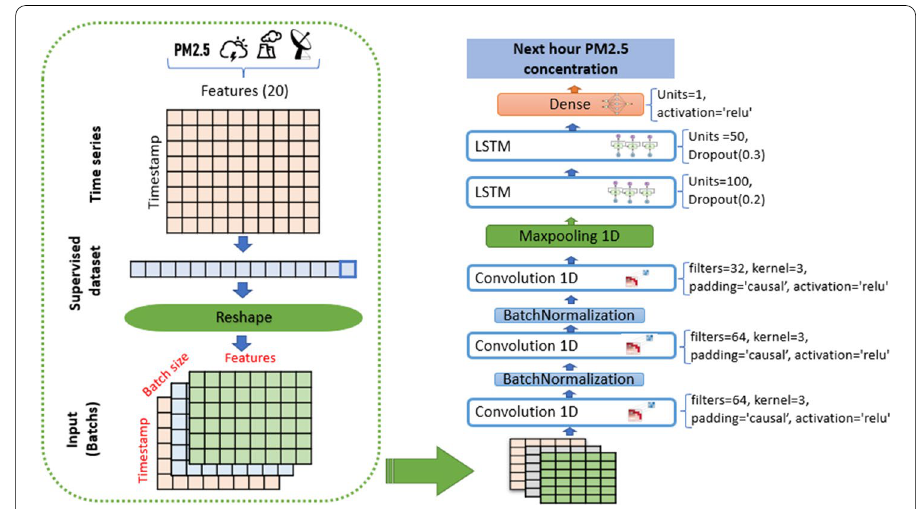
Fig. 12 The architecture of the proposed